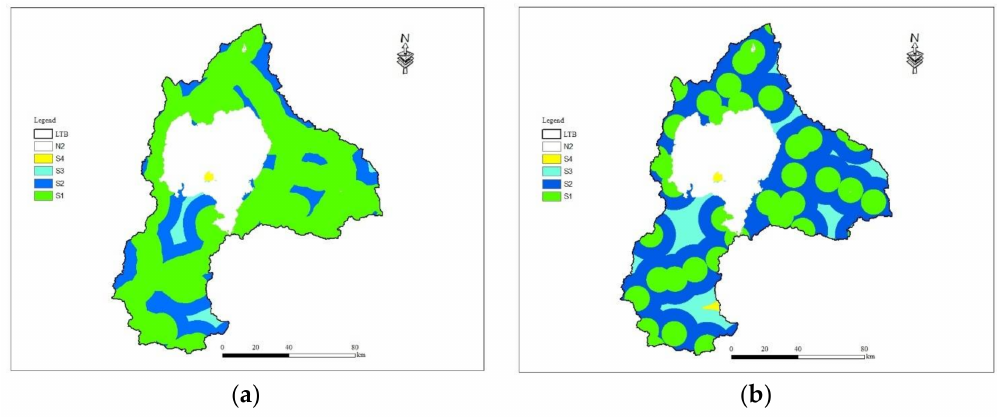
Figure 6. Reclassified factors ( a ) road proximity; and ( b ) town